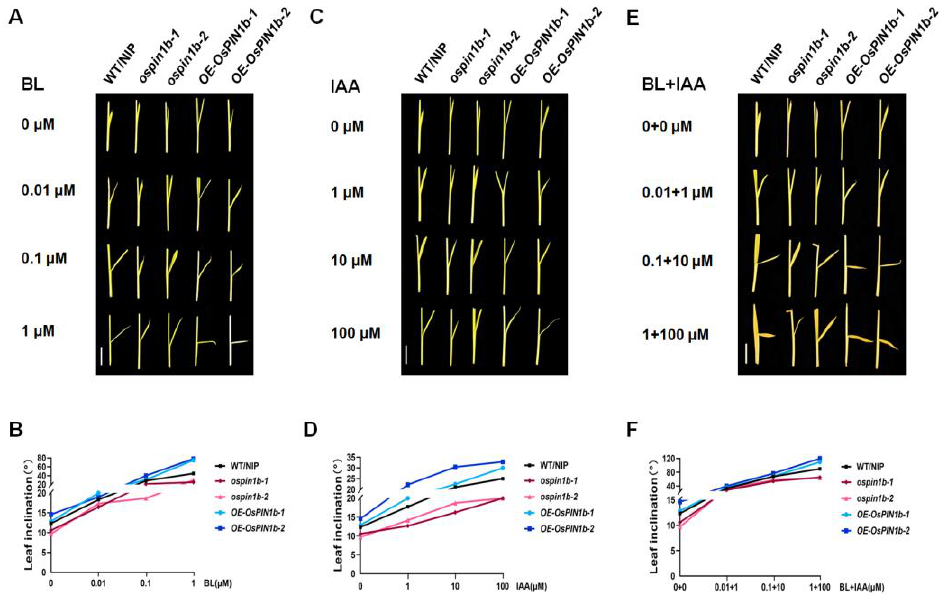
Figure 7. Variation in leaf inclination by BR and IAA treatments. ( A ) Leaf inclination response to 24-eBL treatment in WT/NIP, ospin1b-1 , ospin1b-2 , OE-OsPIN1b-1, and OE-OsPIN1b-2 for 7-day-old seedling. ( B ) The statistical analysis of ( A ). ( C ) Leaf inclination response to IAA treatment. ( D ) The statistical analysis of ( C ). ( E ) Leaf inclination response to 24-eBL + IAA treatment. The concentrations of BL + IAA from top to bottom were 0 + 0, 0.01 + 1, 0.1 + 10, and 1 + 100 µM, respectively. ( F ) The statistical analysis of ( E ). The data in ( B , D , F ) are mean ± SD (n = 10 independent plants). Scale bars = 1 cm.